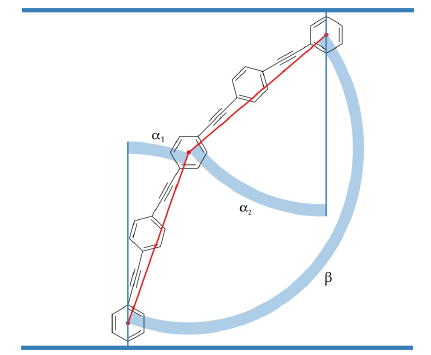
Figure 7. Angels between the bilayer normal and B16/10 backbone ( α 1 and α 2 ) and backbone bending angle β .